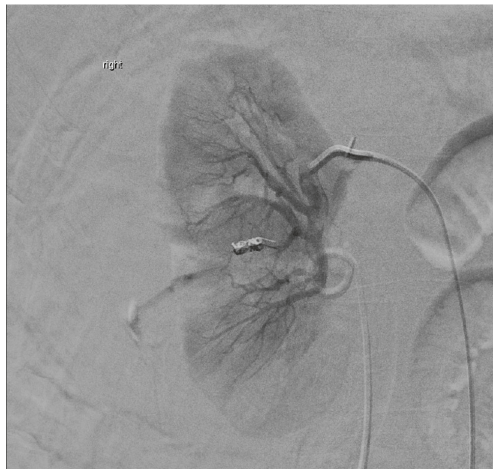
Figure 2: Active contrast extravasation on arteriography.